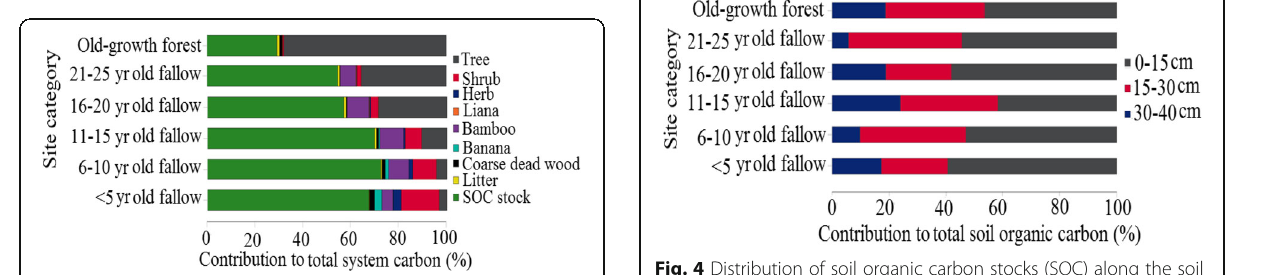
Fig. 3 Contributions of different carbon components to their corresponding total ecosystem carbon stock in the study sites